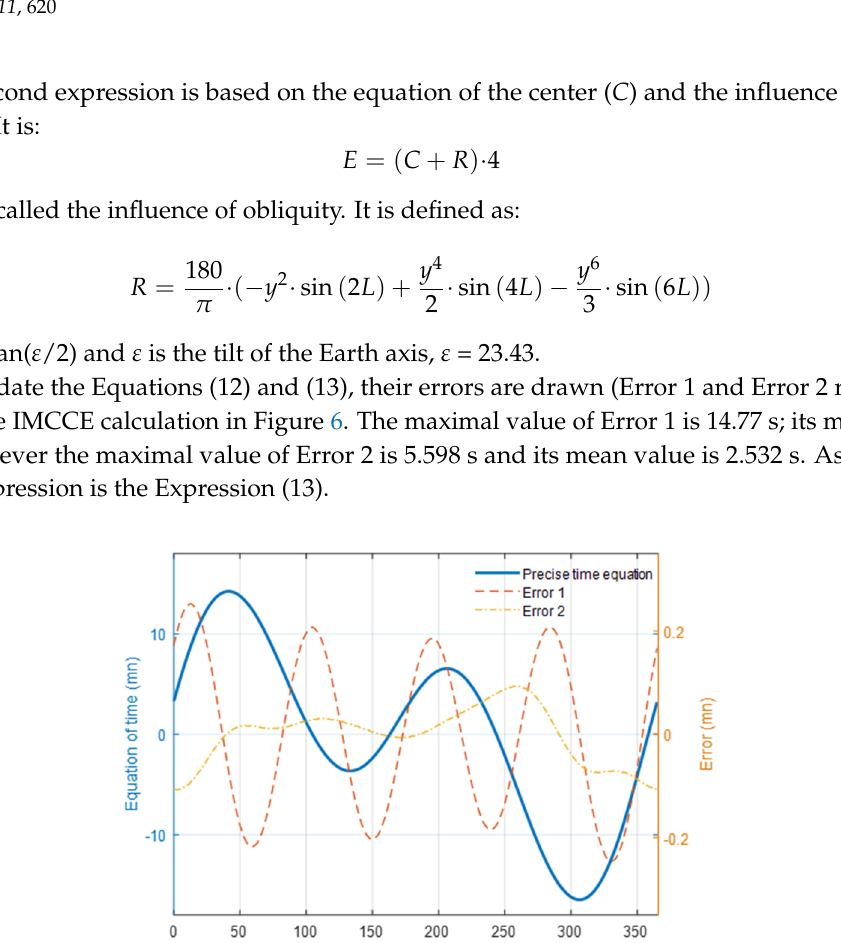
Figure 7. Localization of a point of the Earth: longitude (Lon) and latitude ( ϕ ).